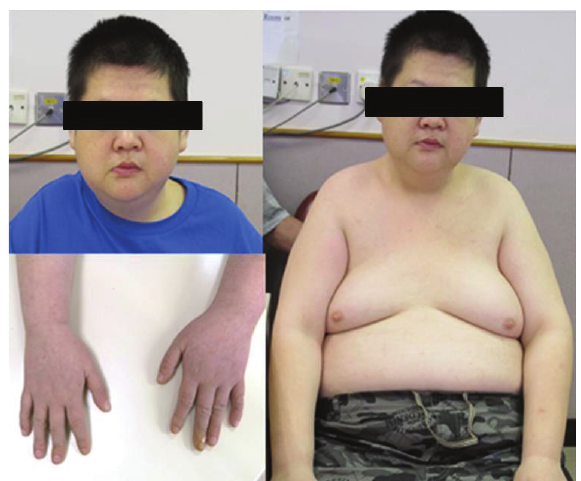
Figure 1: The clinical photos showed there is no facial dysmorphism in this Chinese gentleman, but with fair complexion, bilateral gynecomastia, truncal obesity, and relative small hands.